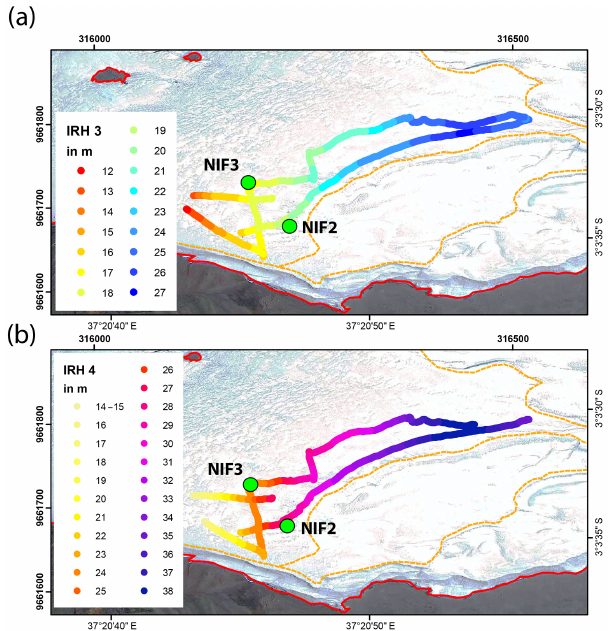
Figure 9. Tracing IRH in a closed course along all 200MHz pro- file. Shown in the colour-coded reflector depth of IRH 3 (a) and IRH 4 (b) . Except for IRH 4 at the eastern end, reflectors can be con- nected at all intersections of two profiles. Coordinates are in UTM